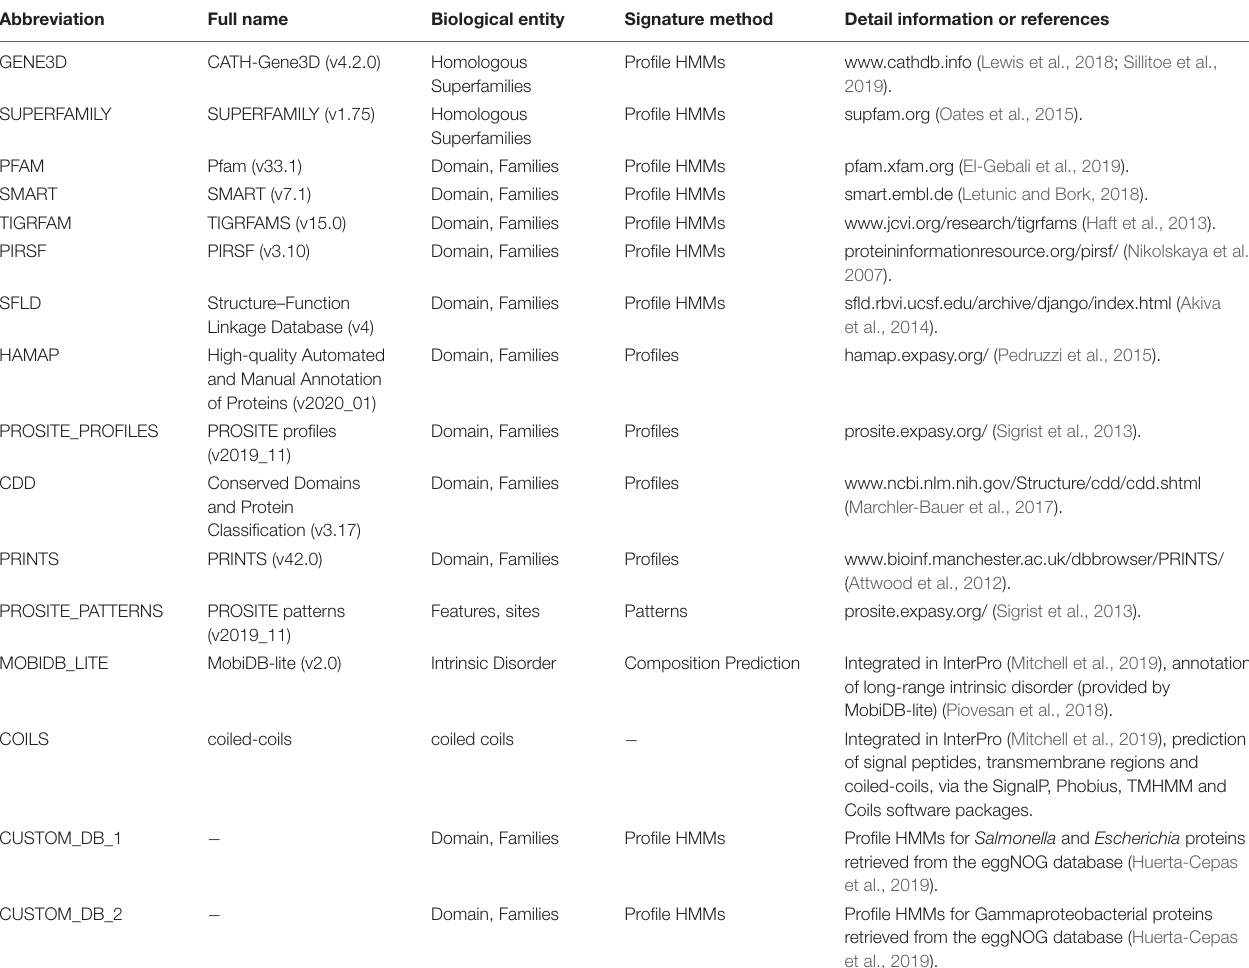
TABLE 1 | Overview of the Seed_databases applied in the